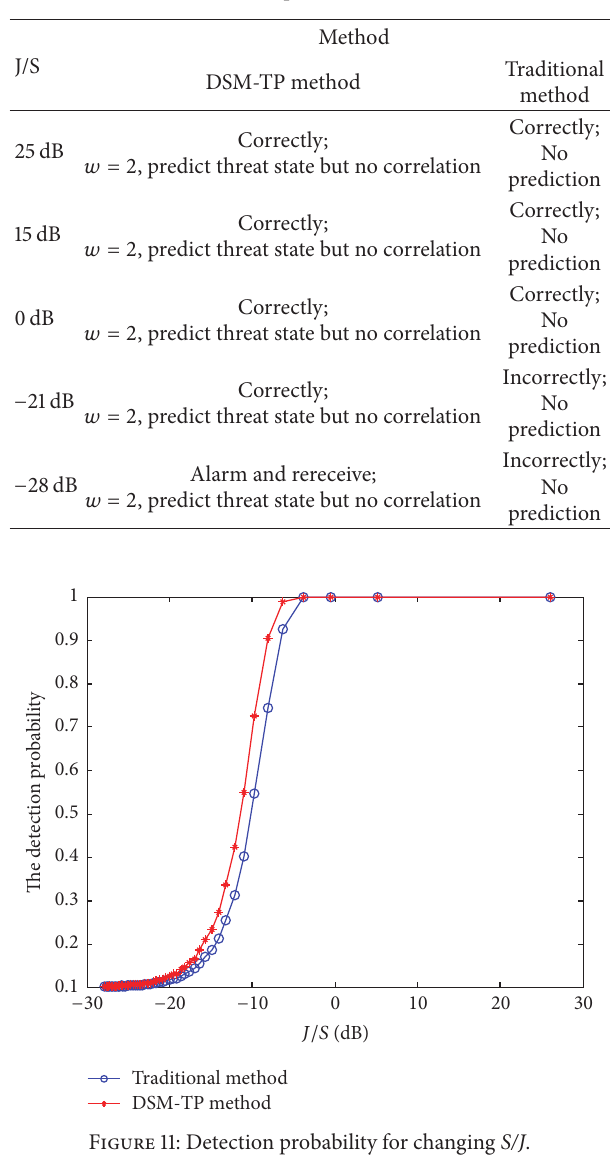
Table 2: Results of threat prediction for the two methods.